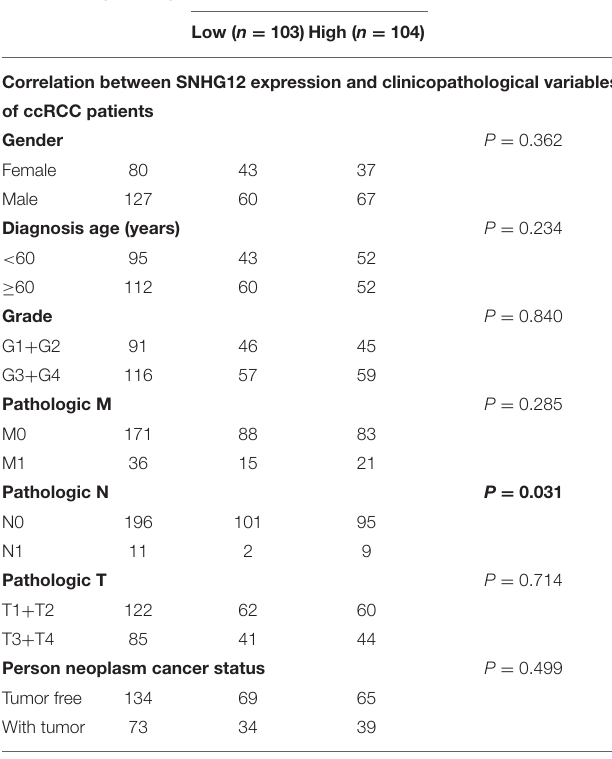
TABLE 2 | Clinical characteristics of study population from TCGA.